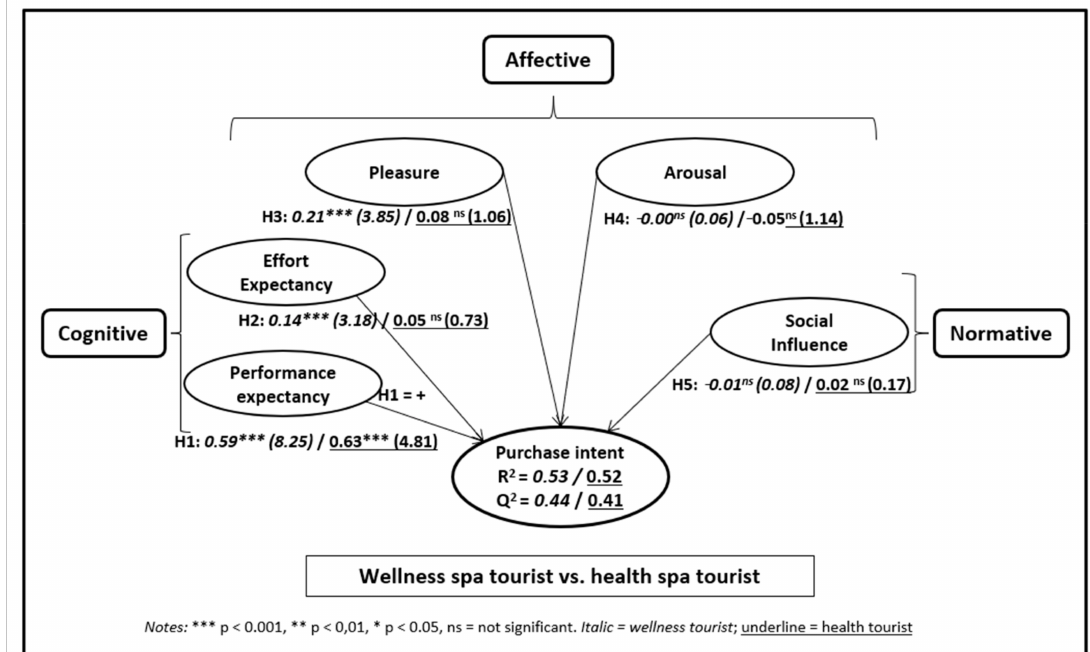
Figure 2. Wellness spa vs. health spa tourist